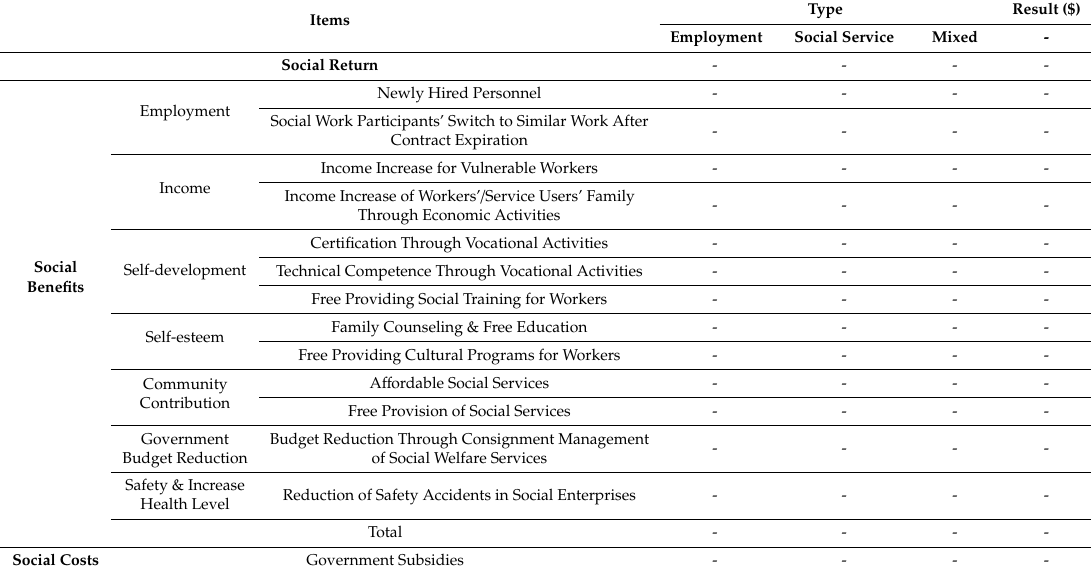
Table A4. Social Value Assessment by